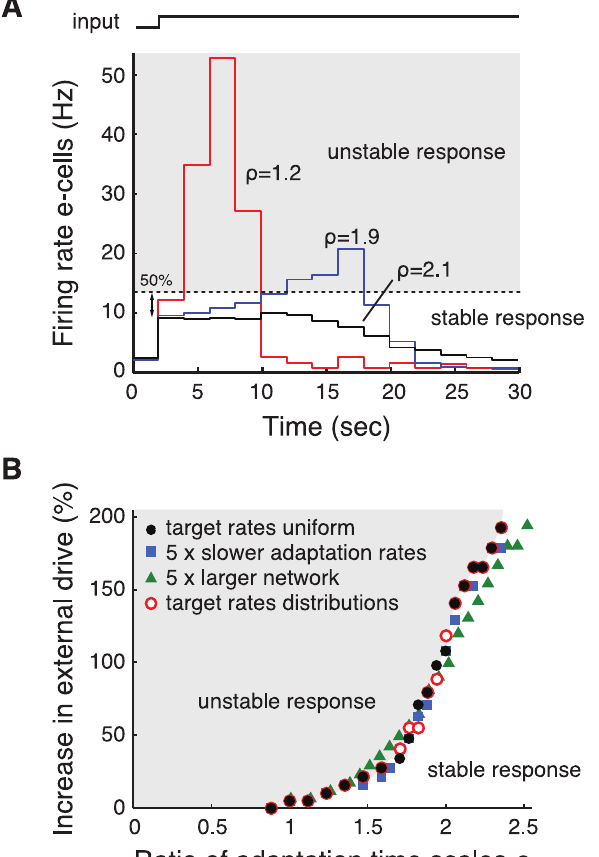
Figure 2. Stable dynamics of HSE controlled networks depends crucially on ratio of inhibitory to excitatory adaptation time scales. A: Response of the excitatory population to a 100% increase of the external drive to both e-cells and i-cells for three different values of r , i.e., the ratio of inhibitory to excitatory adaptation time scales. Mean firing rate of the e-cell population is determined in bins of 2 seconds. The response of the adapting network is considered unstable (gray area) when the population rate grows more than 50% compared to the instantaneous increase following the input step. Note that the adaptation rates are 15 times faster than in the simulations shown in figure 1. B: Relationship between r and the maximum increase in external drive that the network can stably adapt to. This relationship is determined for: the standard network (see Methods) where all cells within a population have equal target rates (filled circles); a network where the adaptation rates are slowed down by a factor 5 (squares); a network with 5 times as many neurons (i.e., 4000 e-cells and 1000 i-cells; triangles); and a network in which the target rates of the individual e- cells and i-cells were randomly chosen from a normal distribution with mean 2 and 8 Hz and standard deviation 0.75 and 3 Hz, respectively (open circles). The compound external drive to e-cells and i-cells before the input increase is 1.2 kHz in the 1000 neuron network and 3.1 kHz in the 5000 neuron network. doi:10.1371/journal.pcbi.1002494.g002 the response function of each population by a threshold-linear function g ½ x (cid:2) z , where g ½ x (cid:2) z ~ 0 if x ƒ 0 , and g ½ x (cid:2) z ~ gx if x w 0 , with gains g e and g i for the excitatory and inhibitory population, respectively. To implement the HSE mechanism, we introduce the variables S e ( t ) and S i ( t ) . The mechanism operates via activity- dependent shifts of the response functions, analogous to the single cell HSE mechanism in the spiking network model. The HSE mechanism shifts the response functions in such a way that the time-